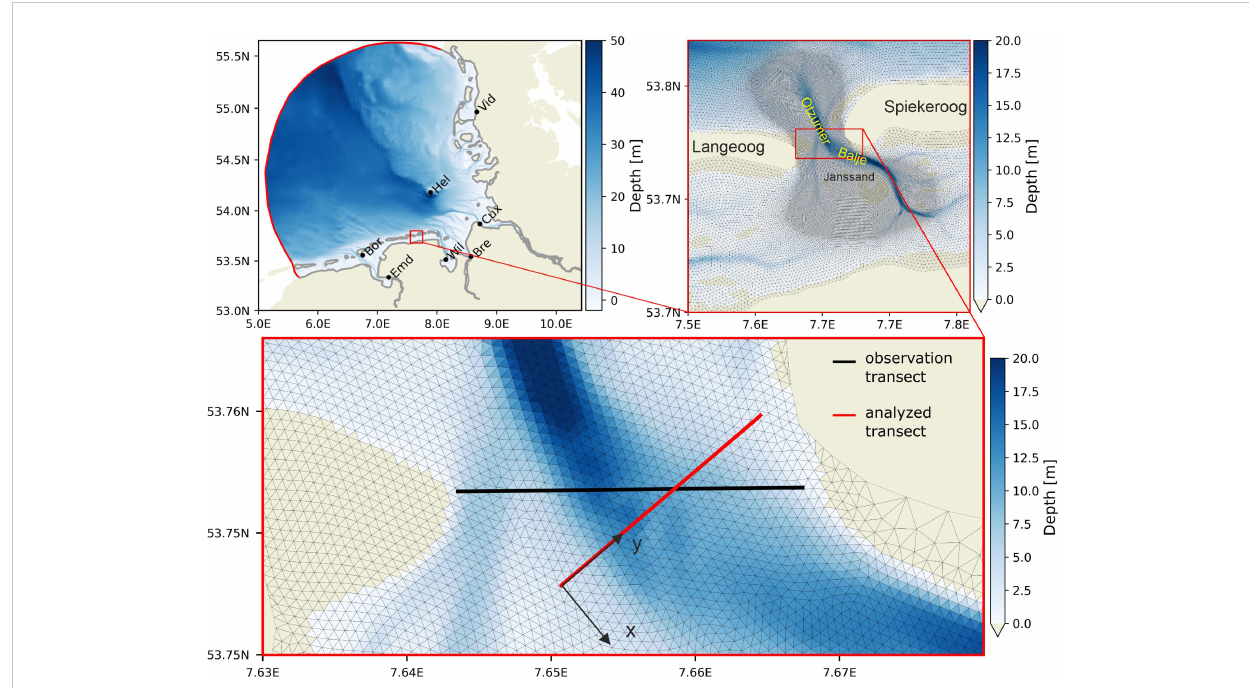
FIGURE 1 Model domain and bathymetry (left) and the magni fi ed box showing the study site Otzumer Balje (right, red box (left)) and the transect location (bottom, red box (right)). The extent of the oceanward domain is indicated by the red line (left). Black dots depict locations of the tide gauge stations. The increased model resolution in the inlet is indicated by the overlayed mesh (right, the dense region corresponds to 50 m). In the magni fi ed plot of the inlet (bottom); the black line marks the transect sampled by the ADCP, and the red line the orthogonal transect of the channel, along which the secondary circulation is